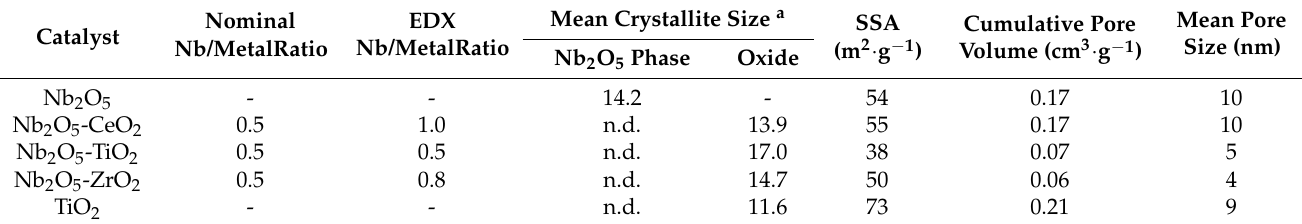
Table 1. Chemical composition (nominal and EDX data) and textural properties of the prepared materials.